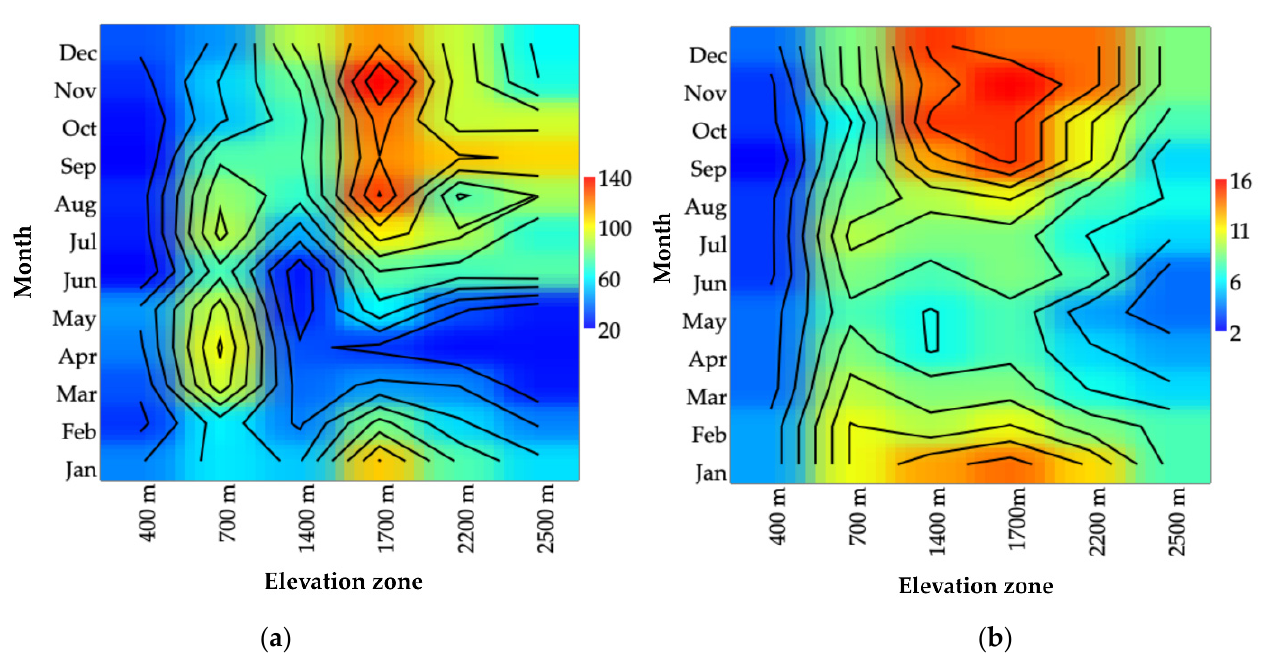
Figure 6. Spatiotemporal variation of black flies in Doi Inthanon National Park. ( a ) Seasonal abundance. ( b ) Seasonal species richness.